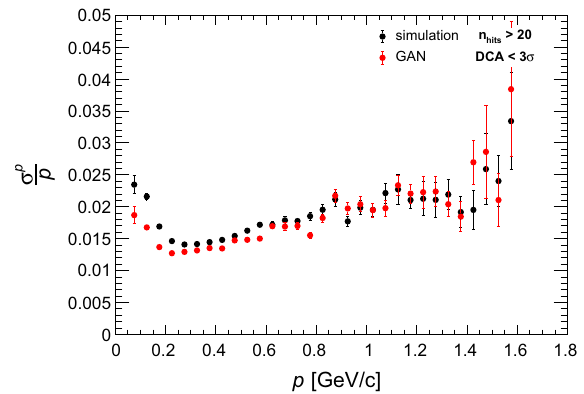
Fig. 5 Momentum resolution as a function of the full